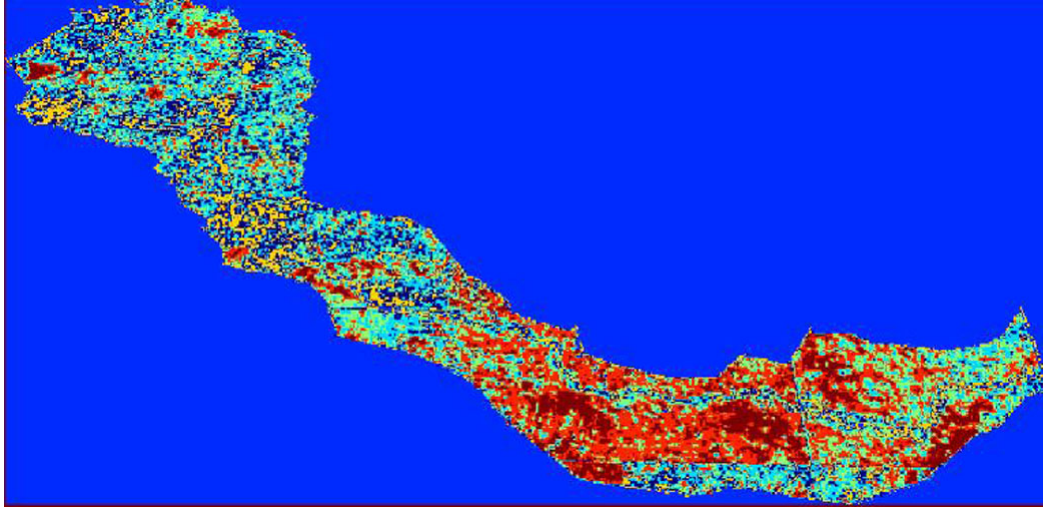
Figure 5: Remote sensing image segmentation of Ajoy river catchment area obtained by K-Means method (for K=7).